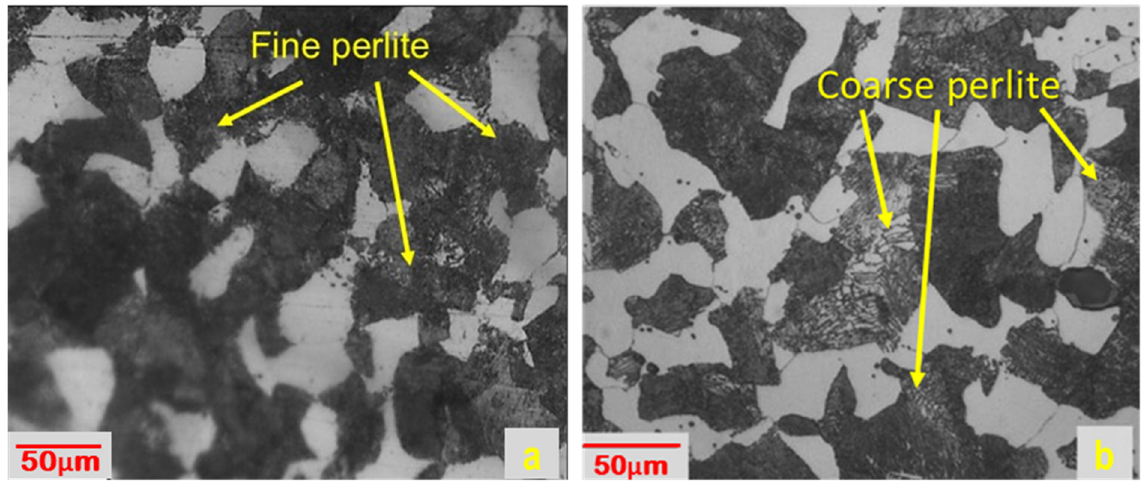
Figure 1. Optical micrograph of AISI 4340 alloy steel: ( a ) Before; and ( b ) After heat treatment.